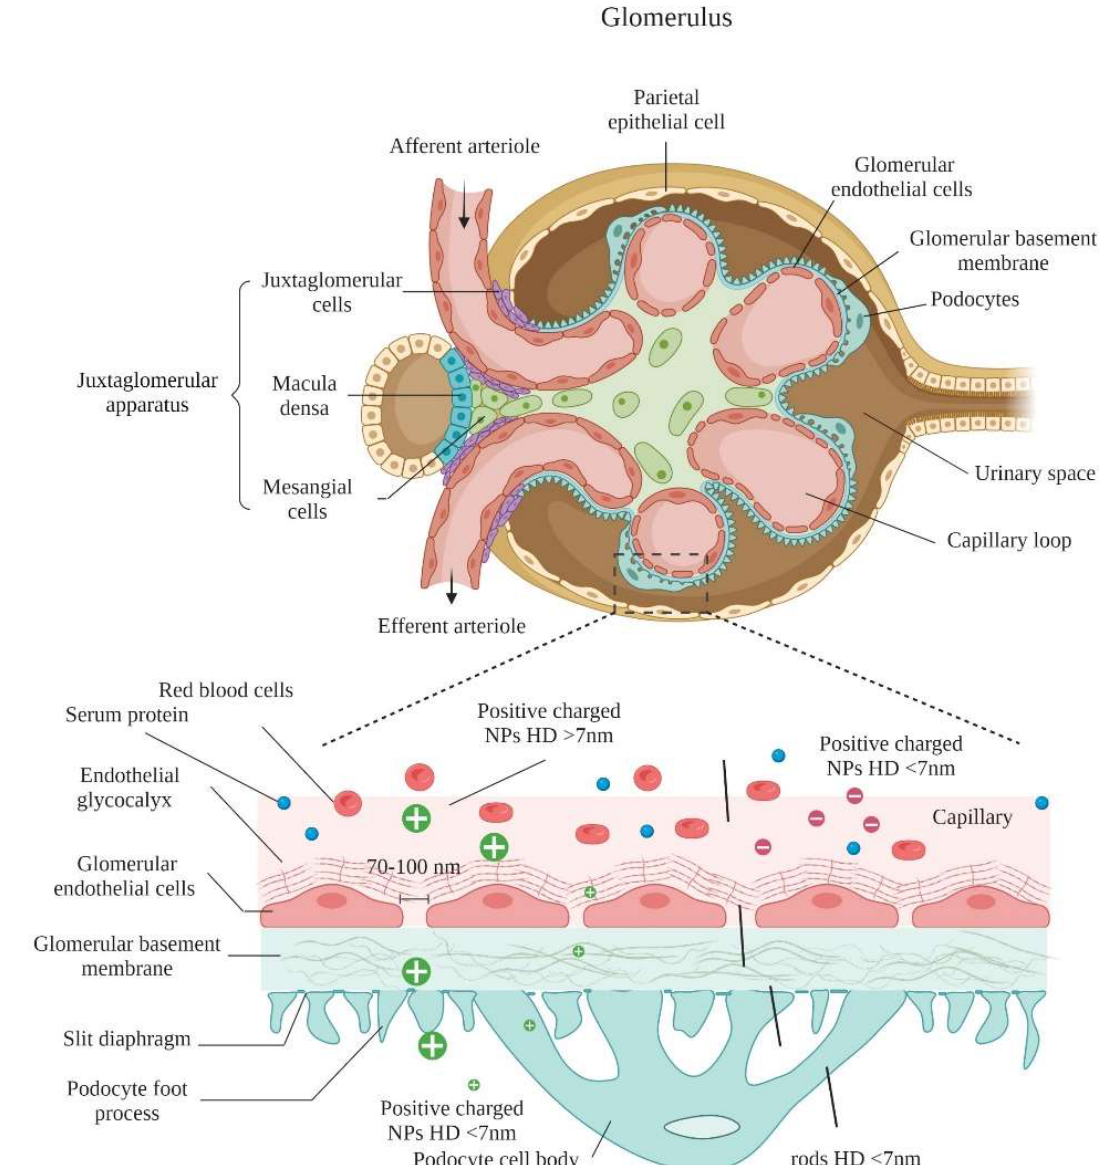
Figure 3. Kidney-targeted drug delivery. The nanoparticles filtration process in the glomerulus as function of their size, charge, and shape. HD indicates hydrodynamic size of the nanoparticles.